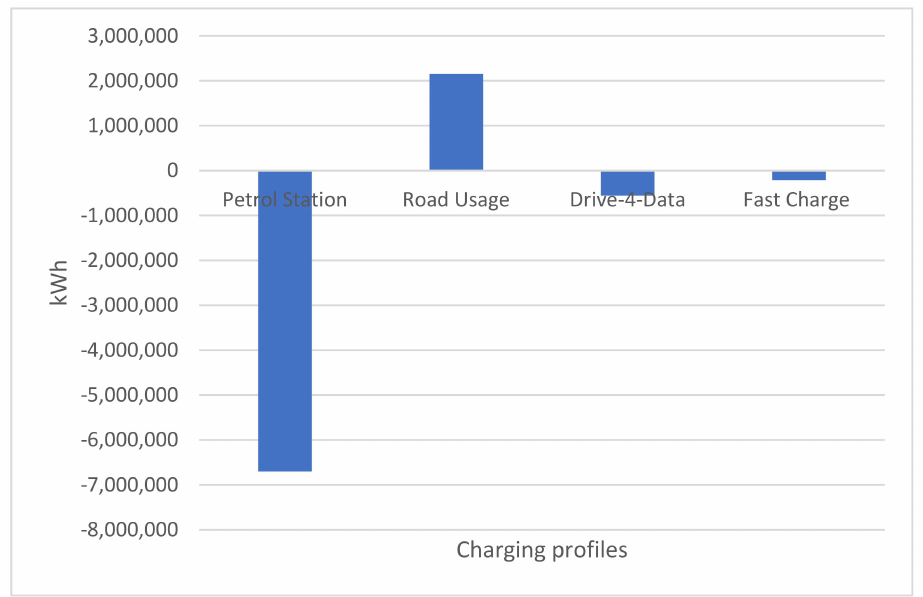
Figure 9. Health rating of the grid-connected system with no storage.